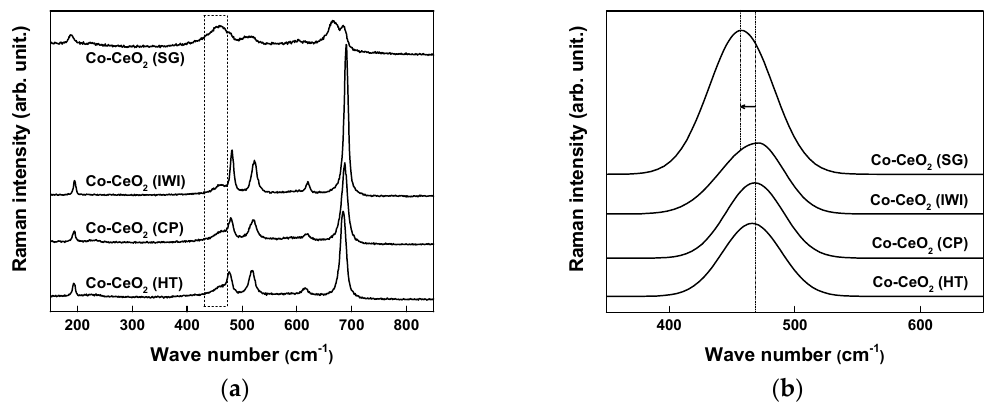
Figure 2. Raman spectroscopy results of Co–CeO 2 catalysts prepared by different synthetic